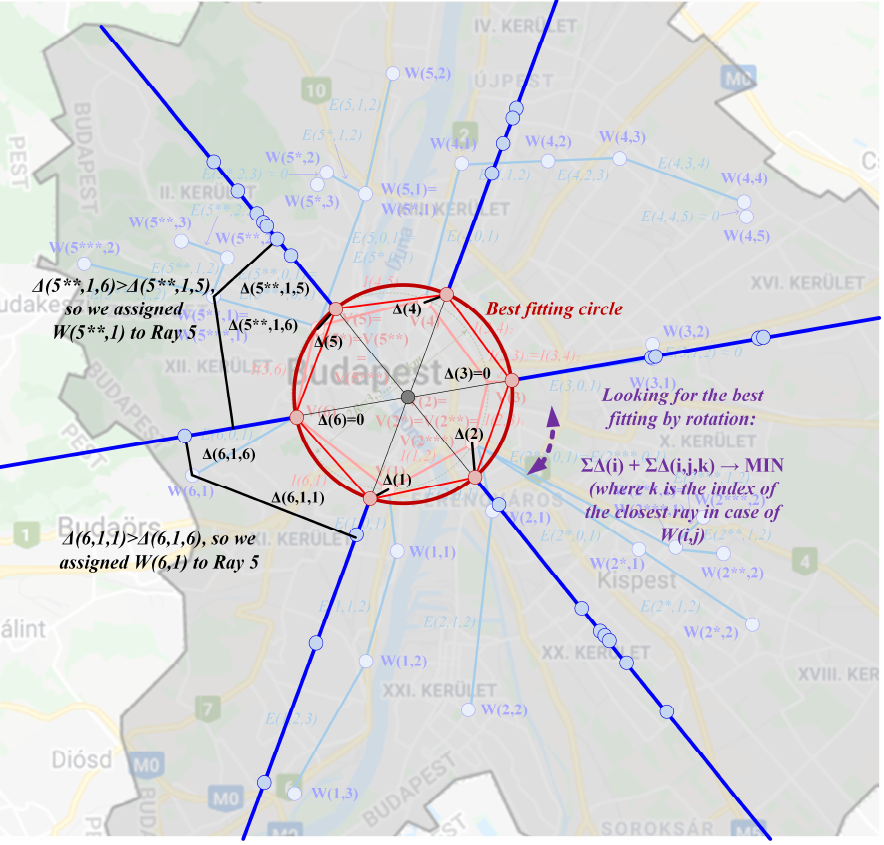
Figure 15. Designation of the reference geometrical model.